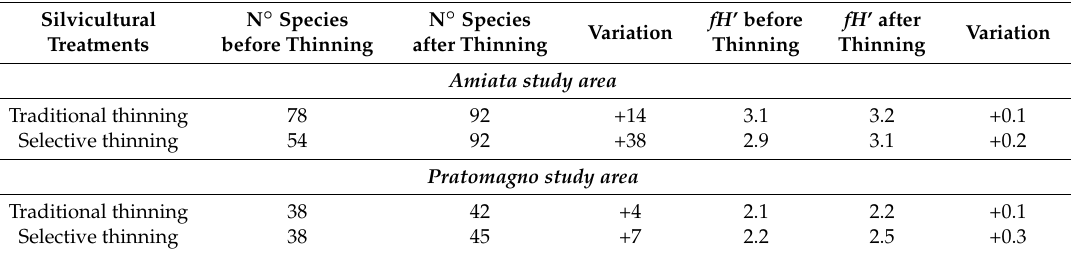
Table 5. Change in the floristic Shannon index ( fH ’) and species richness after thinning in the two study